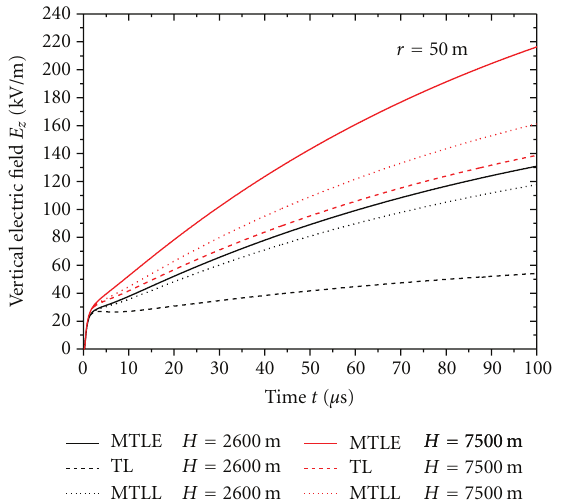
Figure 6: Vertical electric field at 100 km from the channel base for NCBC, three di ff erent models and two channel heights ( H = 2600 m and 7500 m).